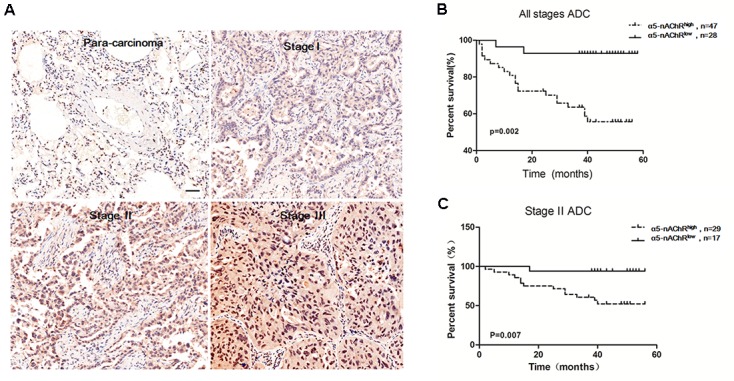
High α5-nAChR expression is associated with shorter survival time in NSCLC patients. (A) Overexpression of α5-nAChR in human NSCLC tissues compared to para-carcinoma tissues (200×). Scale bar, 100 μm. (B) Survival curve of α5-nAChR high expression compared to α5-nAChR low expression in ADC patients. (C) Survival curve of α5-nAChR high expression compared to α5-nAChR low expression for stage II ADC patients.